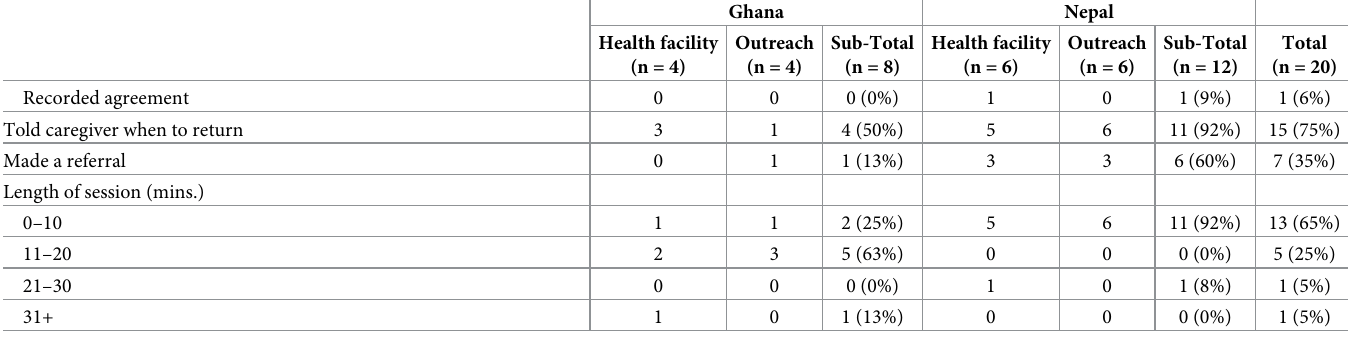
Growth analysis. Most health workers in Nepal described interpreting growth using growth charts and identified children as normal, low weight, or very low weight based on where their weight measurement from a single visit fell on the growth chart. Many in Ghana focused on the growth trend (weight-for-age increasing or decreasing over time). The growth chart in Nepal has red, yellow, and green bands, while the chart in Ghana has colored lines highlighting the standard deviations: green for 0 (median), red for 2 standard deviations above or below the median, and black for 3 standard deviations above or below the